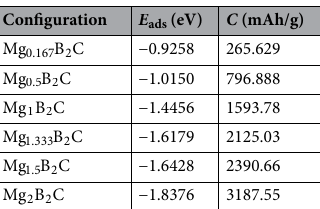
Table 1. The calculated average adsorption energy ( E ads ) and theoretical capacities ( C ) for B 2 C with Mg adsorbed atoms.